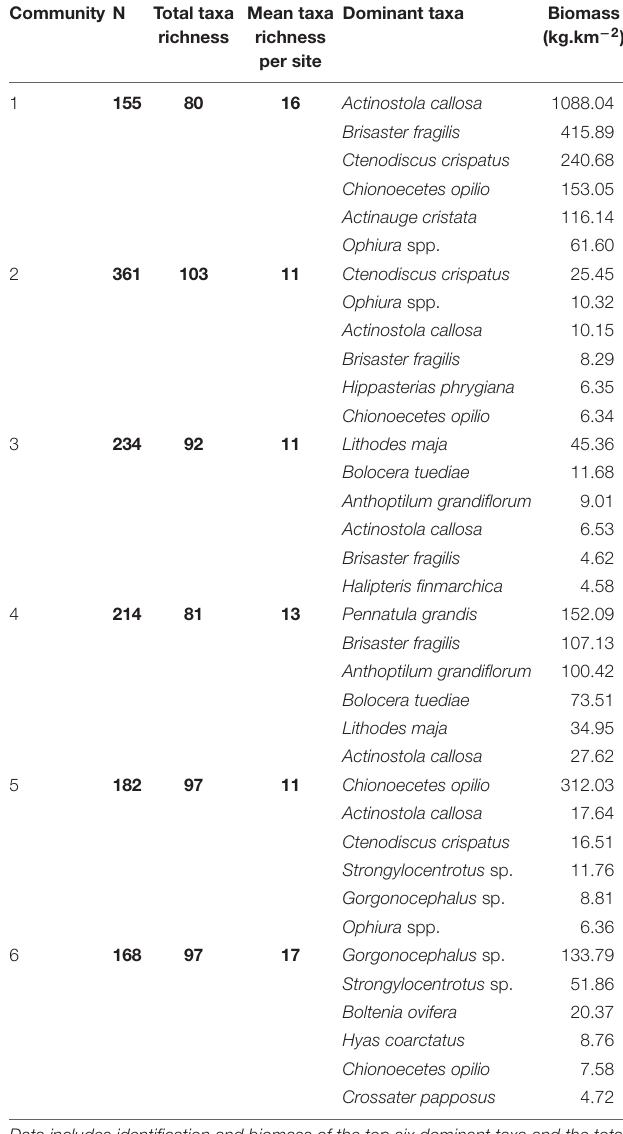
TABLE 1 | Summary statistics for six epibenthic community types identified in the estuary and Gulf of St. Lawrence. Community